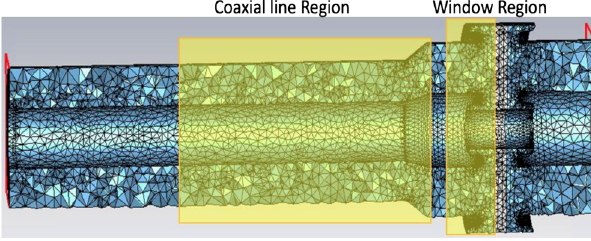
FIG. 7. Multipacting simulation regions.